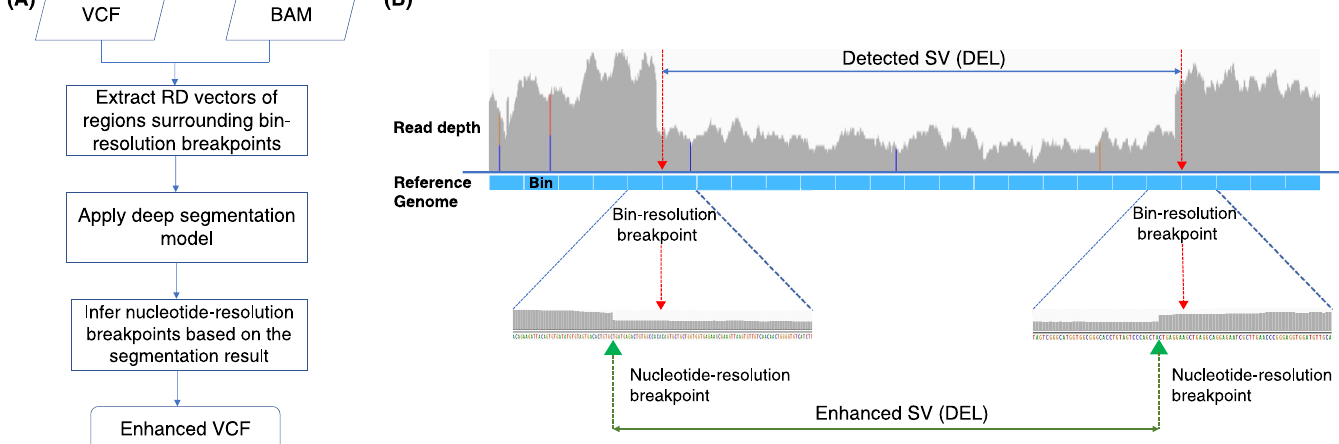
Fig 1. (A) Overall pipeline of RDBKE for enhancing an RD-based SV caller with a deep segmentation model. The initial SV predictions in bin resolution are provided as a VCF file. (B) Example illustrating the enhancement of bin-resolution breakpoints using RDs surrounding breakpoint